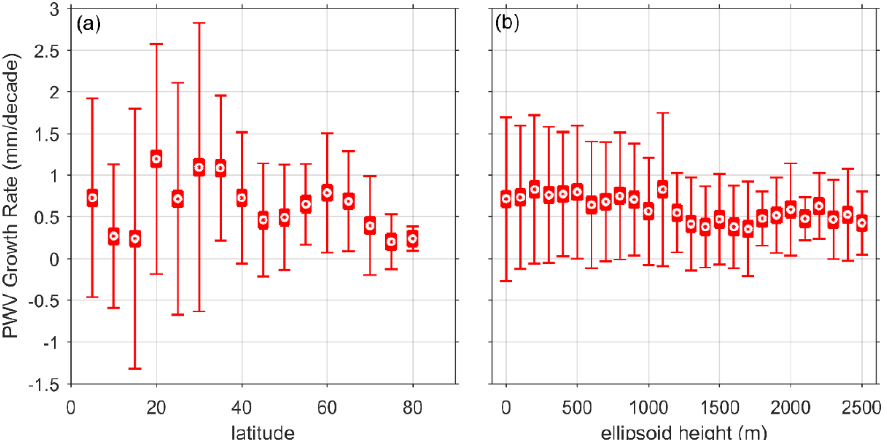
Figure 11. Distribution of PWV growth rates with latitude and ellipsoid height. ( a ) PWV growth rate with latitude; ( b ) PWV growth rate with ellipsoid height. The error bars are STDs of PWVs of stations in the same latitude/height grouping area. Note: the groups for latitude and ellipsoid height are in intervals of 5 ° and 100 m, respectively.